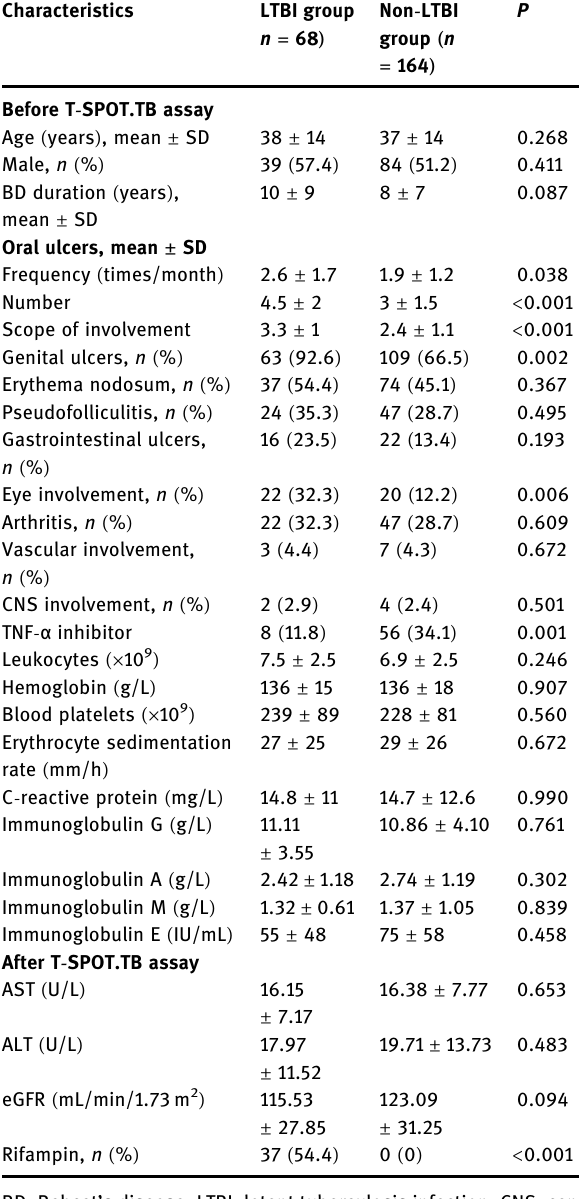
Table 2: Demographics, clinical features, and laboratory indexes